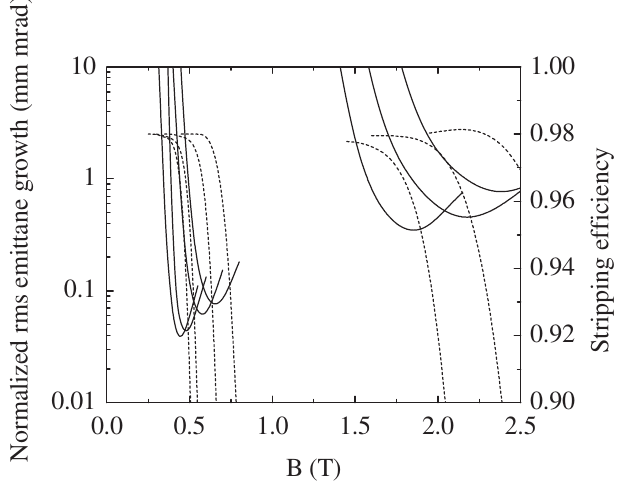
FIG. 4. Emittance growth (solid line) and stripping efficiency (dashed line) as functions of uniform transverse magnetic field B for different parabolic states. The four parabolic states on the left belong to the 3rd principal state and have the following sequence from left to right: f 0 ; 2 ; 0 g , f 0 ; 1 ; (cid:8) 1 g , f 1 ; 0 ; (cid:8) 1 g , f 2 ; 0 ; 0 g . The three parabolic states on the right belong to the 2nd principal state and have the following sequence from left to right: f 0 ; 1 ; 0 g , f 0 ; 0 ; (cid:8) 1 g , f 1 ; 0 ; 0 g .